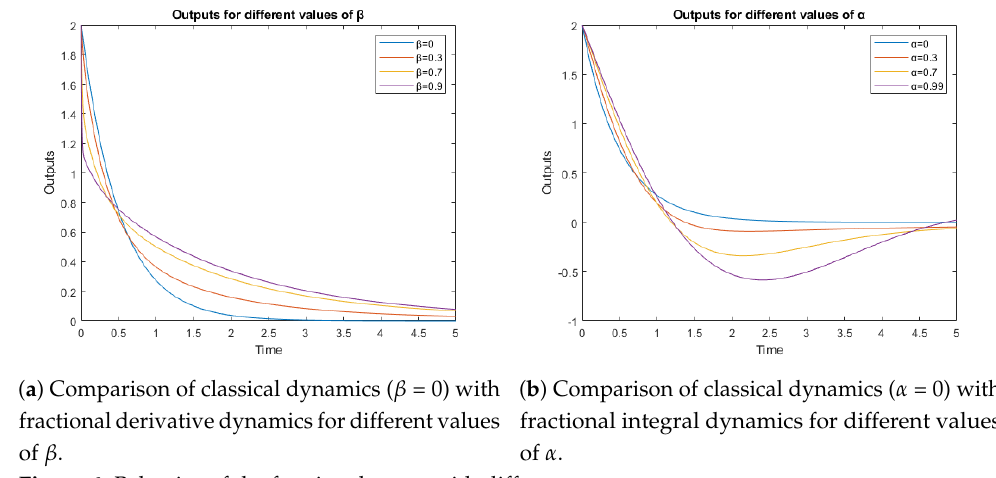
Figure 6. Behavior of the fractional terms with different